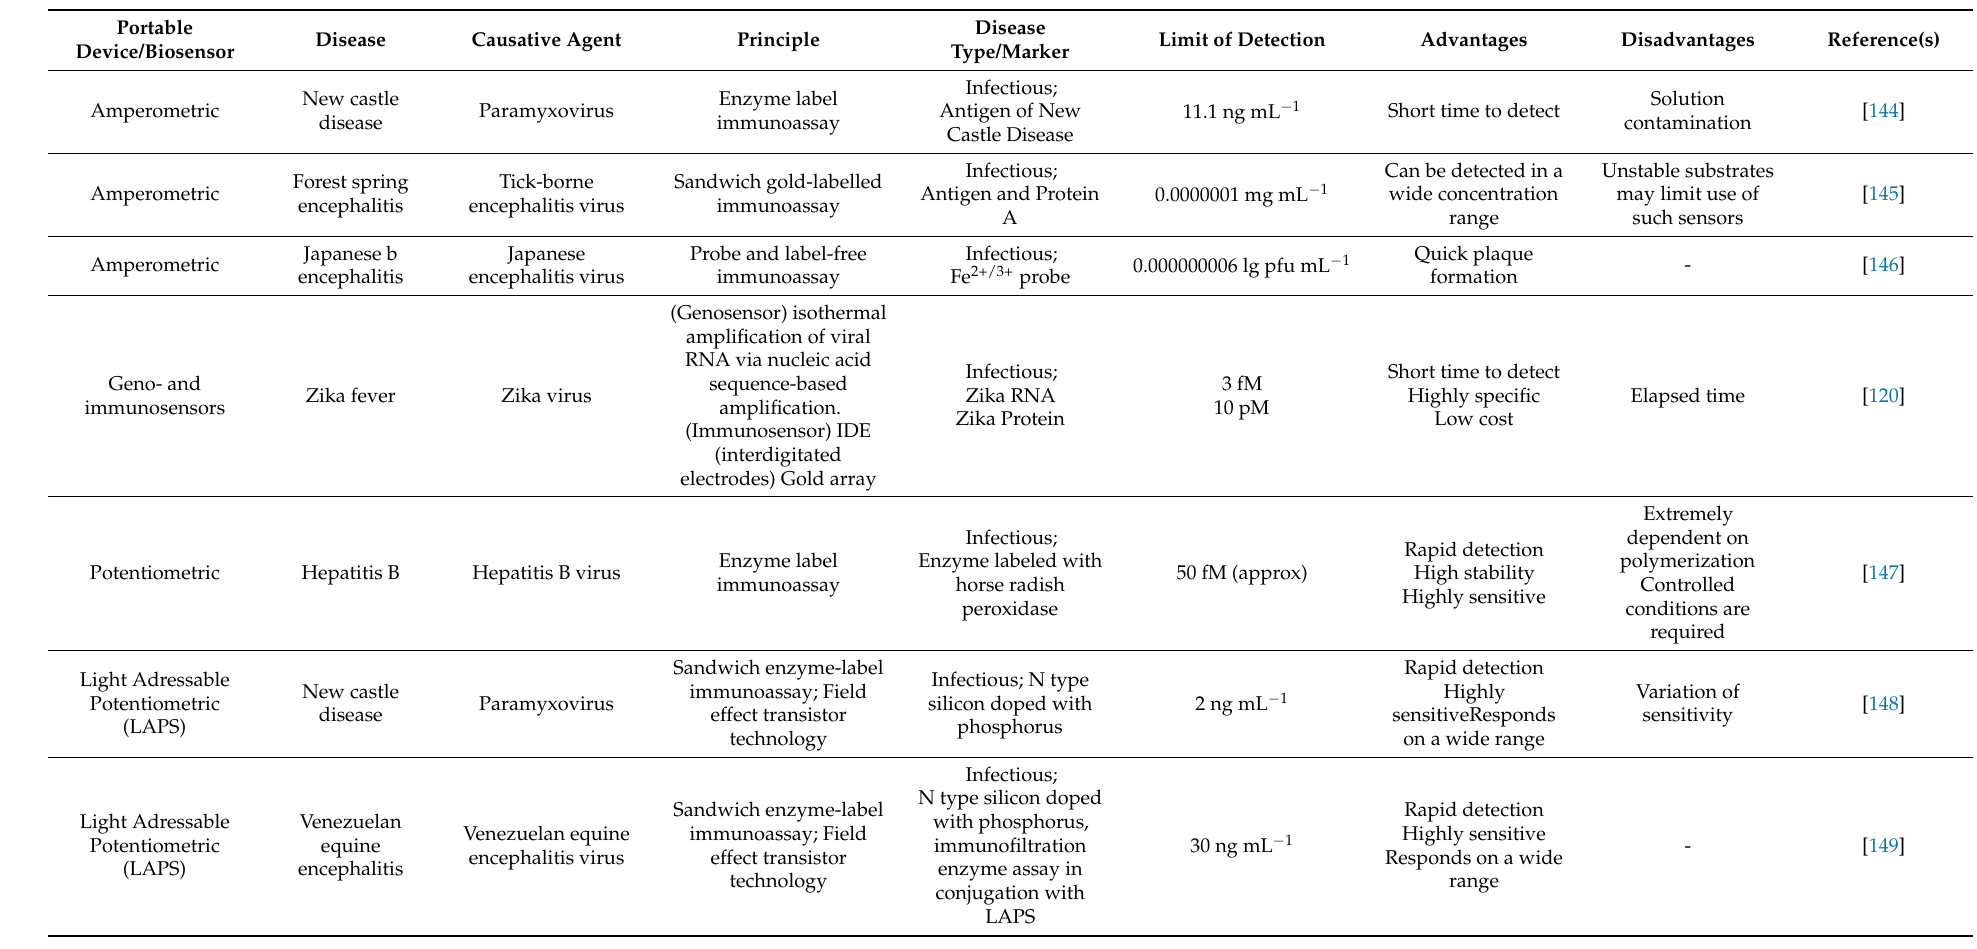
Table 1. Table representing portable devices and their use in infectious and non-infectious